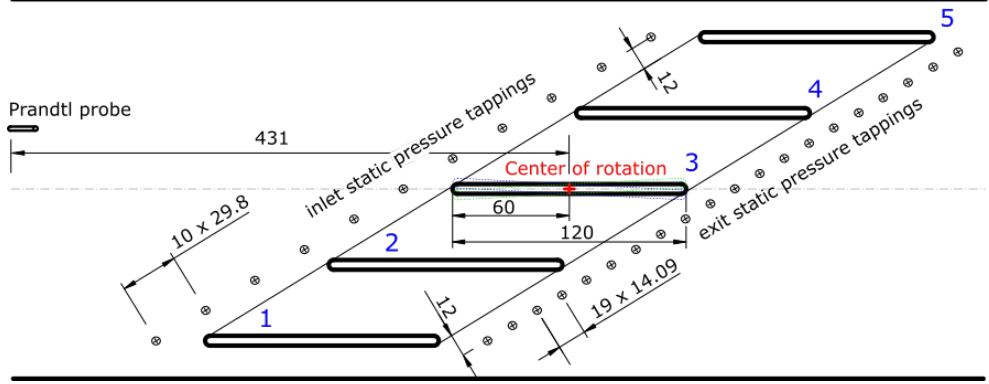
Figure 9. Scheme of the test section and measurement setup, dimensions are given in